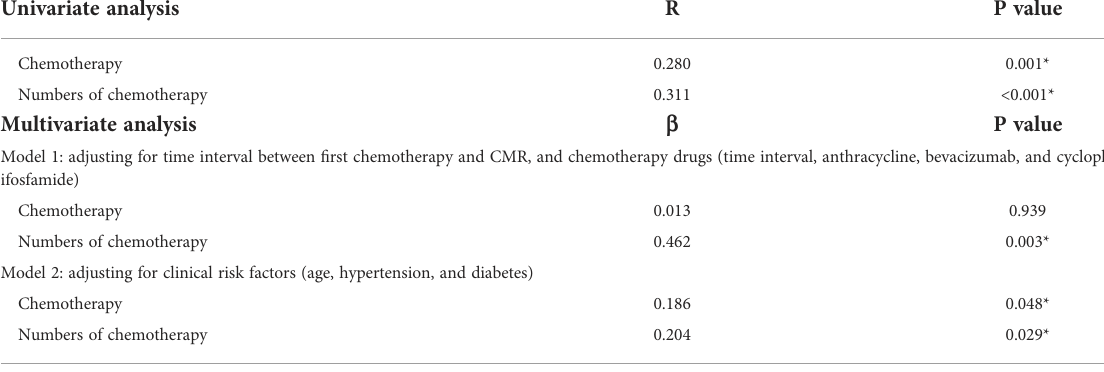
TABLE 2 The association between chemotherapy and myocardial T2 variation. Univariate analysis Chemotherapy